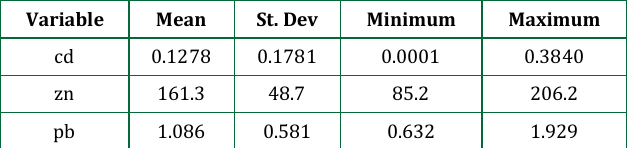
Table 2: Descriptive Statistical Analysis of Estimated Values of cd Contaminant Level (mg/kg) in Male Samples